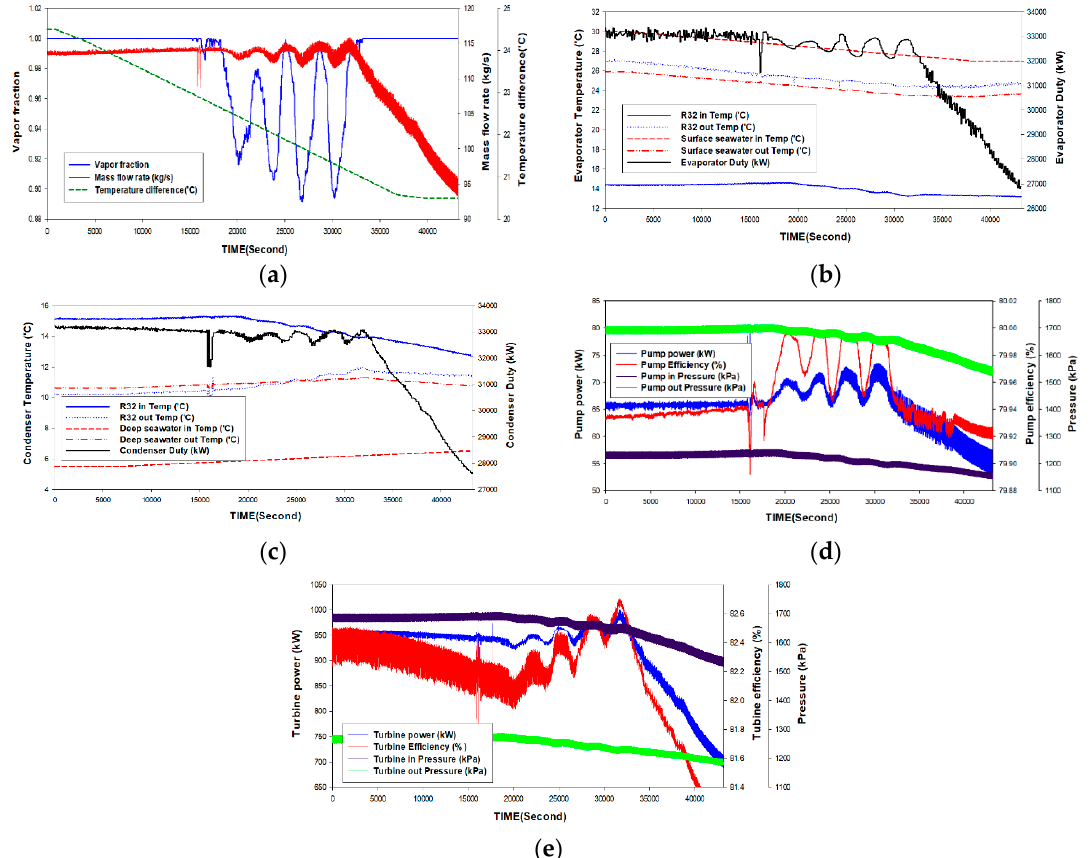
Figure 7. Dynamic variations in turbine and heat exchange without PID controller according to the surface and deep water temperature differences: ( a ) vapor fraction and flow rate; ( b ) temperatures and heat capacity of the evaporator; ( c ) temperatures and heat capacity of the condenser; ( d ) power and efficiency of refrigerant pump; ( e ) turbine output and efficiency.